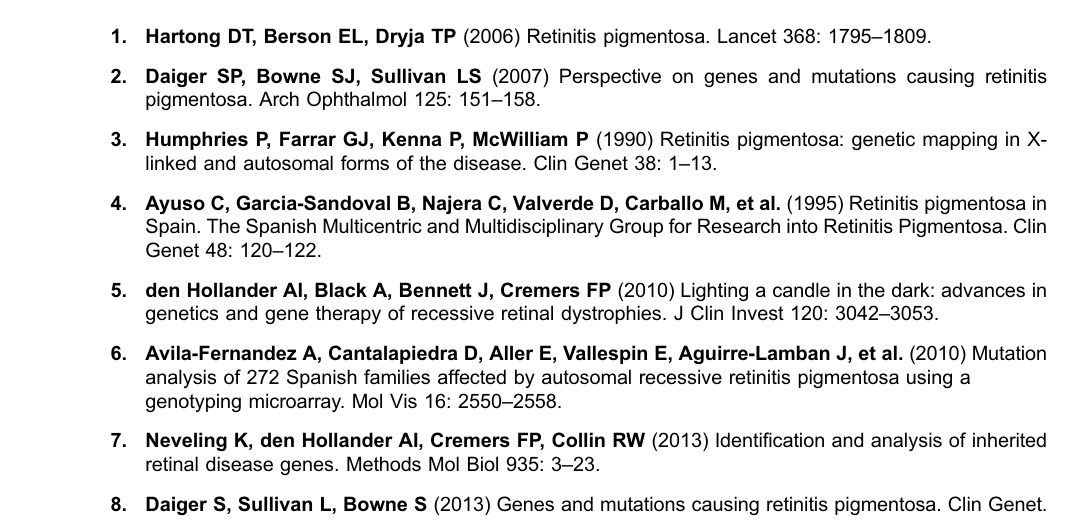
S1 Table. Quality of the exome data and variants identified in each